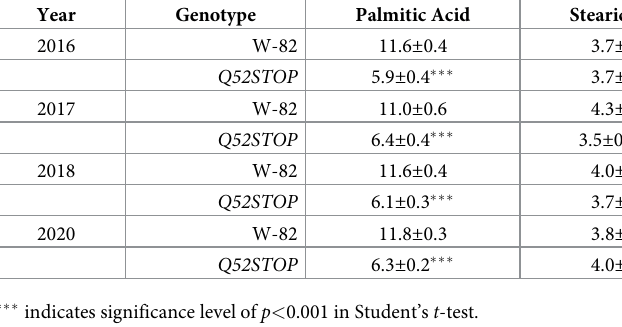
Table 1. Fatty acid profiles of FATB1a Q52STOP mutants and wild type Williams-82 field grown seed.